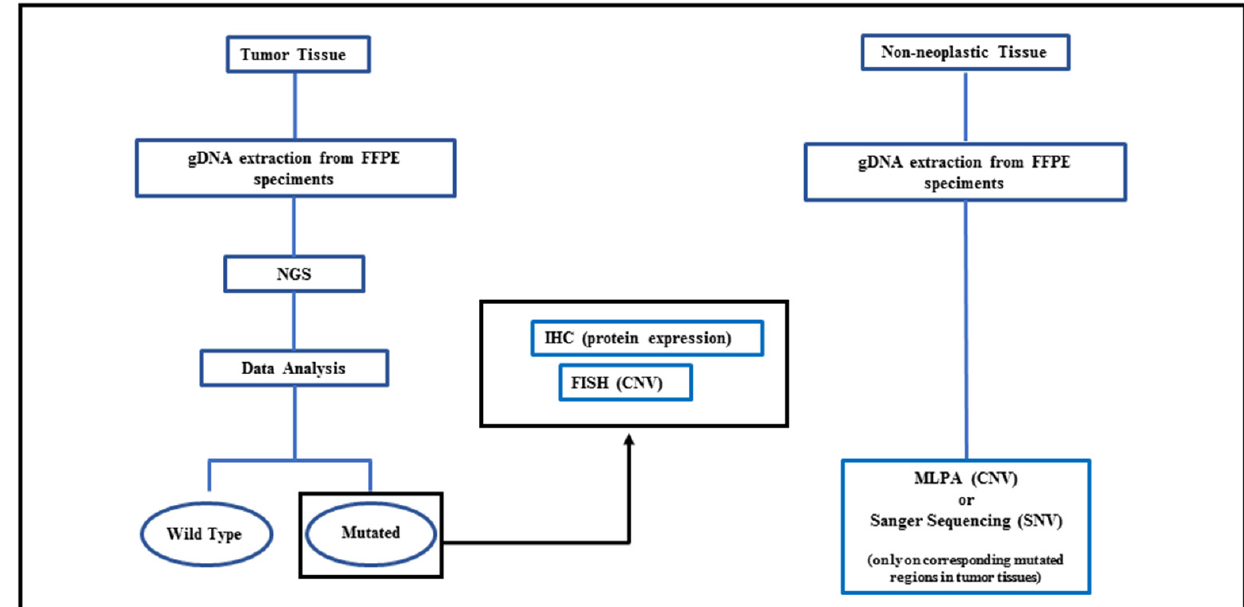
Figure 1. Flow-chart of overall methodology used in this study.